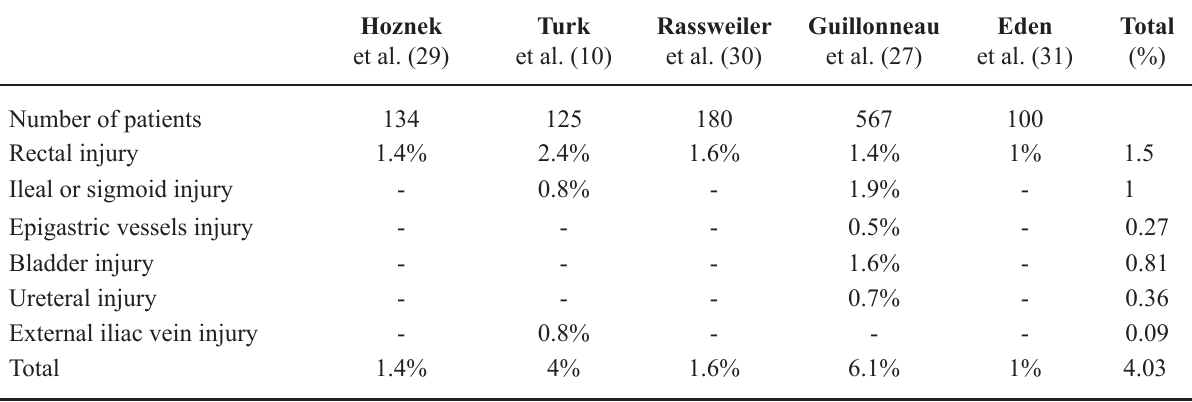
Table 3 – Intraoperative morbidity of laparoscopic radical prostatectomy in early series with more than 100